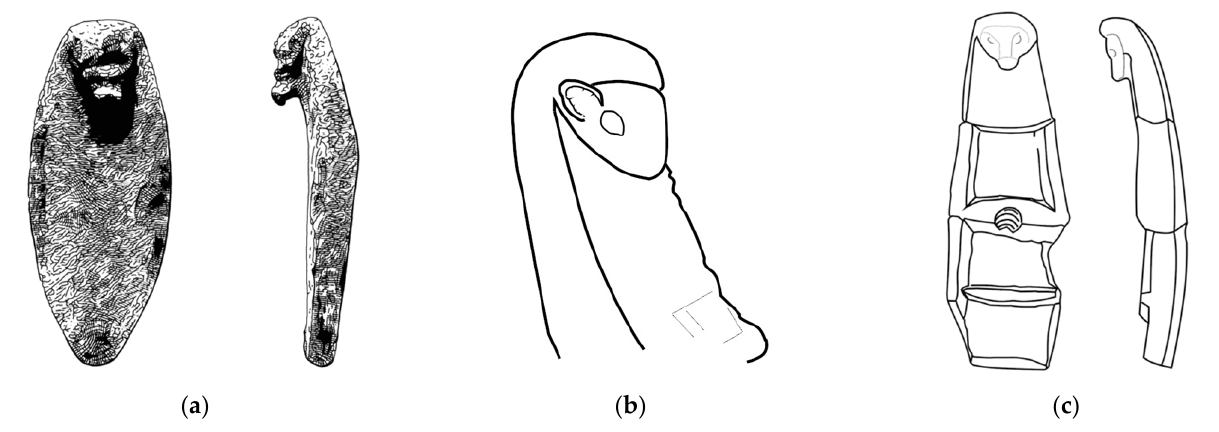
Figure 3. ( a ) Faience model hedgehog-head boat found in the temple of Satet, Elephantine. Adapted by author from Dreyer (1986, pl. 37 [202]) ( b ) Fragment of limestone model hedgehog-head boat found at Giza. Redrawn by author after Tavares et al. (2014, p. 554, fig. 19). ( c ) Pottery model hedgehog-head boat found at Tell Ibrahim Awad. Redrawn by author after van Haarlem (1996, p. 197, fig. 1).